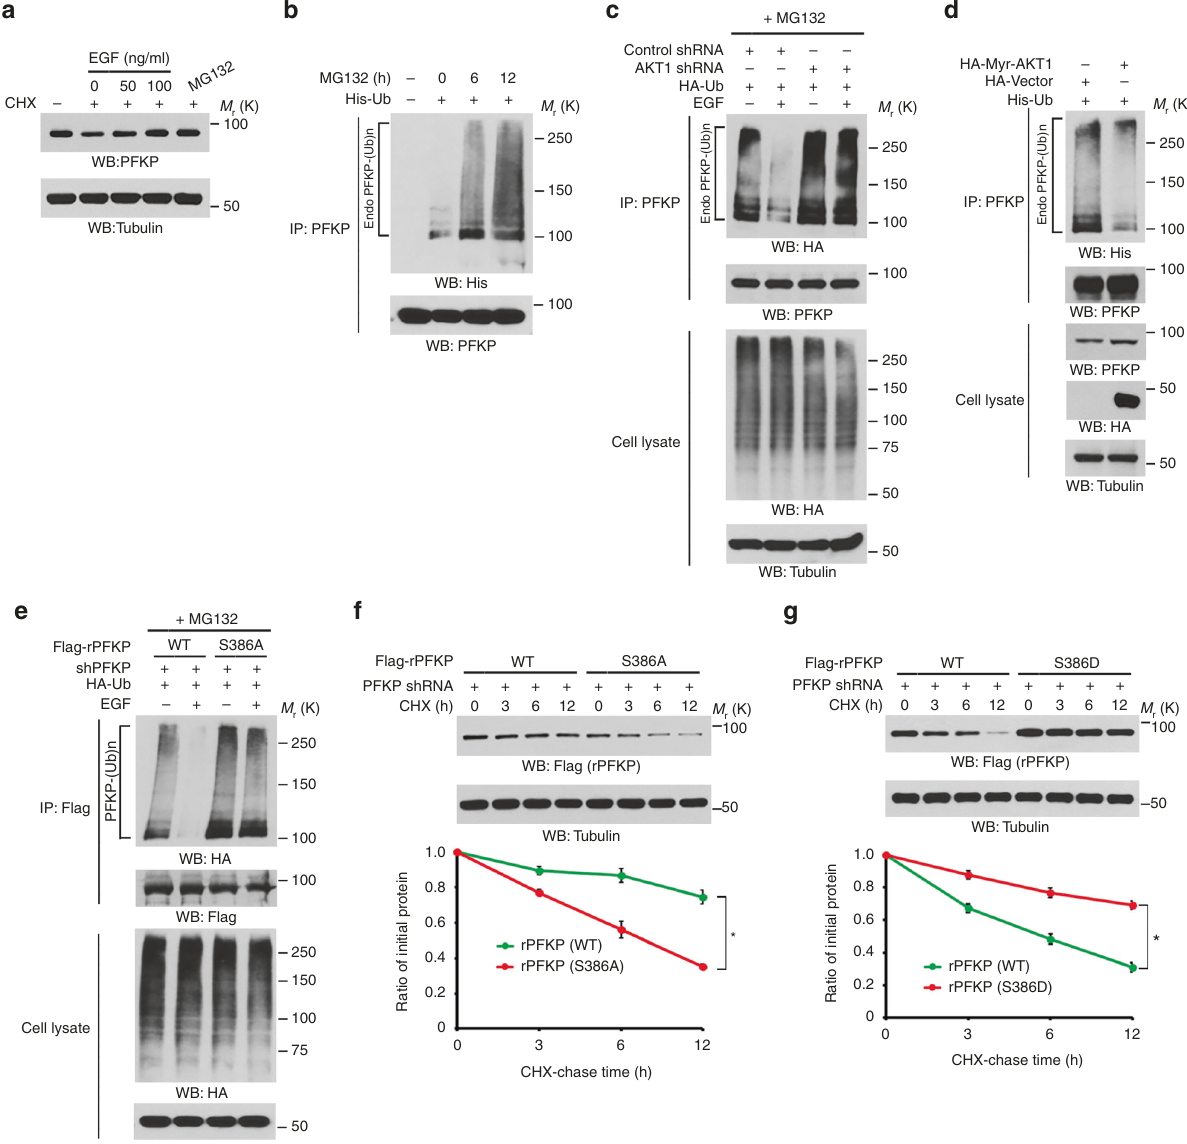
Fig. 4 AKT-dependent PFKP Ser386 phosphorylation blocks ubiquitylation and degradation of PFKP. Immunoblotting analyses were performed with the indicated antibodies. a Serum-starved U251 cells were stimulated with various dosages of EGF for 12 h in the presence or absence of CHX (100 μ g ml − 1 ). The proteasome inhibitor MG132 (10 μ M) was added to the cells 6 h before cell harvesting. b 293T cells were transfected with His-Ub for 24 h and then treated with MG132 (10 μ M) for the indicated periods of time. The cells were harvested with a guanidine-HCl-containing buffer. Immunoprecipitation was performed with an anti-PFKP antibody. c U251 cells with stable expression of an AKT1 shRNA or a control shRNA were transfected with HA-Ub and then treated with or without EGF (100 ng ml − 1 ) for 60 min. MG132 (10 μ M) was added to the cells 6 h before they were harvested with a guanidine-HCl- containing buffer. Immunoprecipitation was performed with an anti-PFKP antibody. d 293 T cells were co-transfected with HA-vector or HA-Myr-AKT1 and His-Ub. The cells were harvested with a guanidine-HCl-containing buffer. Immunoprecipitation was performed with an anti-PFKP antibody. e PFKP- depleted U251 cells with reconstituted expression of WT Flag-rPFKP or Flag-rPFKP S386A mutant were transfected with HA-Ub and then stimulated with or without EGF (100 ng ml − 1 ) for 60 min. MG132 (10 μ M) was added to the cells 6 h before they were harvested with a guanidine-HCl-containing buffer. Immunoprecipitation of PFKP was performed with an anti-Flag antibody. f PFKP-depleted U87/EGFRvIII cells with reconstituted expression of WT Flag-rPFKP or Flag-rPFKP S386A mutant were treated with CHX (100 μ g ml − 1 ) for the indicated periods of time. The quanti fi cation of Flag (rPFKP) levels relative to tubulin levels is shown. Data represent the means ± s.d. of three independent experiments. * P < 0.01, based on the Student ’ s t test. g PFKP-depleted 293 T cells with reconstituted expression of WT Flag-rPFKP or Flag-rPFKP S386D mutant were treated with CHX (100 μ g ml − 1 ) for the indicated periods of time. The quanti fi cation of Flag (rPFKP) levels relative to tubulin levels is shown. Data represent the means ± s.d. of three independent experiments. * P < 0.01, based on the Student ’ s t